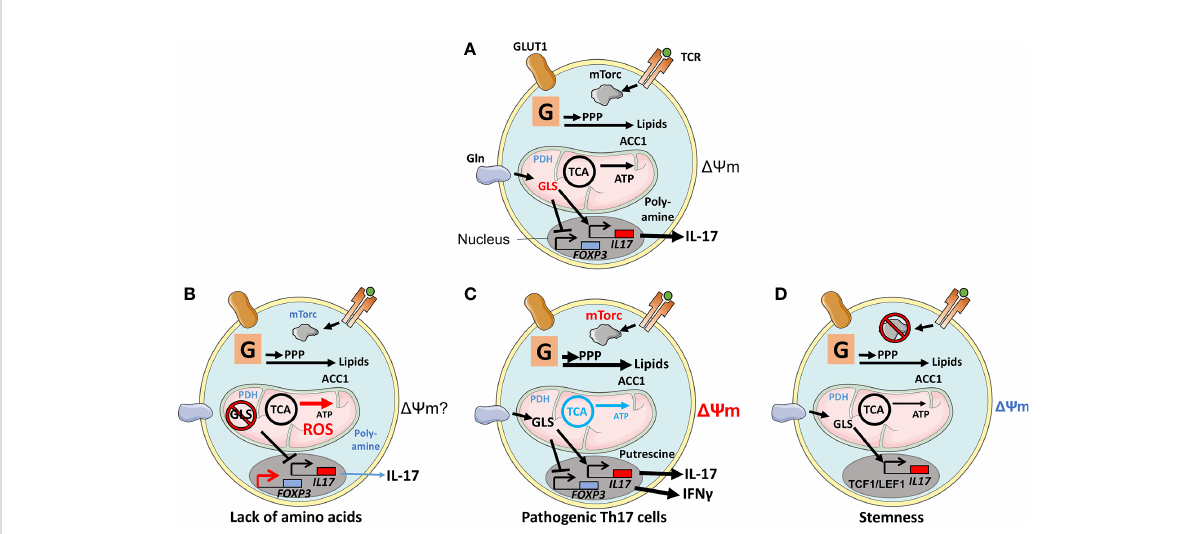
FIGURE 1 Physiological and experimentally induced metabolic states of Th17 cells. (A) After T cell receptor (TCR) engagement, Glucose transporter 1(GLUT1) is upregulated in support of glycolysis (denoted as a G within a square). TCR engagement also augments mechanistic target of rapamycin (mTORC1) activity via Akt/PI3K, leading to cell differentiation. Products generated by glycolysis are utilized in the pentose-phosphate pathway (PPP) and in lipid biogenesis; the latter was regulated by Acetyl-CoA carboxylase 1 (ACC1) but not by mitochondrial anaplerosis, as the cells have limited expression of Pyruvate dehydrogenase (PDH1). Anaplerosis is driven by amino acids, such as glutamine that is imported through the amino acid transporter SLC1A5 and metabolized by glutaminase 1 (GLS1). The metabolite 2-Hydroxyglutarate (2-HG), generated by Glutamic-oxaloacetic transaminase 1 (GOT1), suppresses the activity of the FOXP3 promoter. Other amino acid metabolites favor an epigenetic con fi guration that promotes the Th17-cell transcriptional program. (B) Deprivation of amino acids glutamine, serine, or methionine or ablation of GLS1 or of an enzyme involved in the one- carbon pathway Bifunctional methylenetetrahydrofolate dehydrogenase/cyclohydrolase (MTHFD2) or inhibition of the poly-amine pathway prevents Th17 cell proliferation. Increased ROS production, perhaps due to the lack of glutathione and substrate (succinate) for mitochondrial electron transport, alters epigenetic con fi guration to favor FOXP3 expression and Treg-mediated suppressive activities. (C) Pathogenic Th17 cells, signi fi ed by active mTORC1, lack of OXPHOS, production of IFN g , and high DY m, rely on the polyamine pathway and putrescin. (D) Ablation of mTORC1 and reduced DY m result in Th17 cells expressing stemness markers T-cell factor 1 (TCF1) and Lymphoid enhancer-binding factor 1